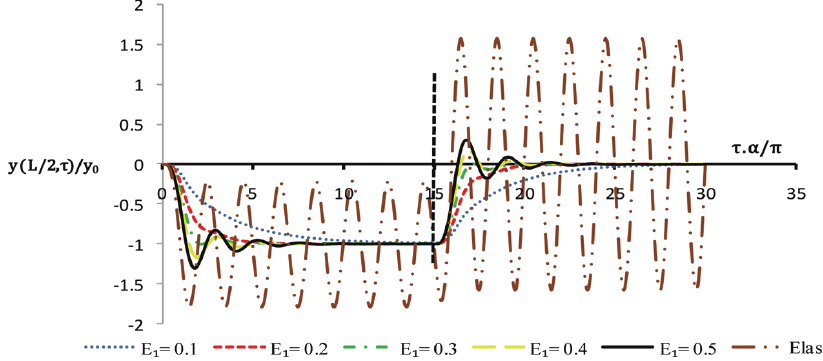
Fig. 9. DLF in terms of τ · α/π for α = 1, K = 1 for Elastic(Elas) case K is in fi nity and E 1 = 1.